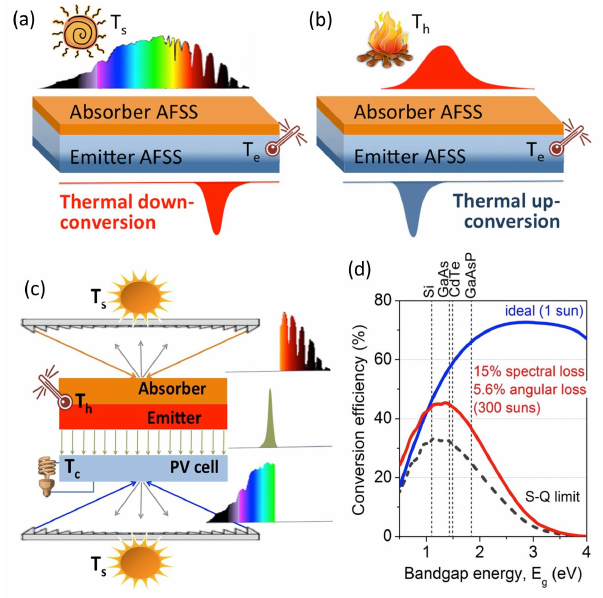
Fig. 8. Thermal up- and down-conversion of photon energy. (a, b) Schematics of thermal down- (a) and up-converters (b) based on the use of angular- and spectrally selective surfaces for the con- trol of thermal emission. (c) Conceptual scheme of a solar energy conversion platform based on a PV cell enhanced by the thermal up-converter [208]. (d) Theoretically predicted maximum achiev- able eflciency of the device shown in (c) as a function of the PV cell electron